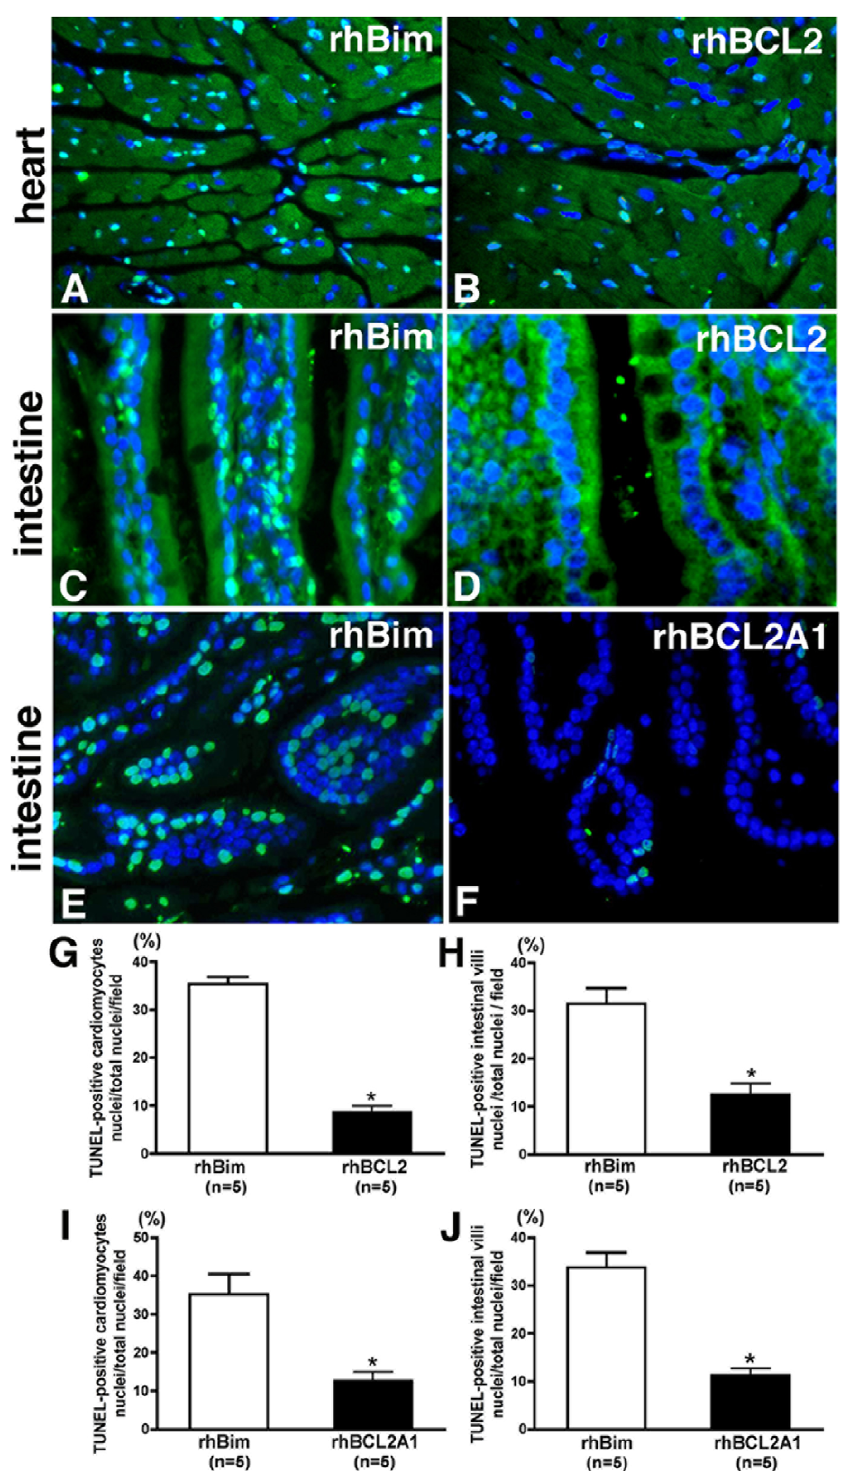
Figure 2. Treatment with rhBCL2 or rhBCL2A1 reduces apoptosis in intestine and myocardium following CLP. Animals were treated with a single i.p. injection of 1 m g rhBim or rhBCL2 or rhBCL2A1 at 18 hours prior to CLP. Tissues were removed and processed at 24 hours following CLP. In the photomicrograph (A-F) TUNEL-positive cells are labeled with FITC (green) and nuclei are labeled with DAPI (blue). Panels A and B shows myocardium from mice treated with rhBim (A) or rhBCL2 (B). Panels C-F show intestinal villi from mice treated of rhBim (C, E), rhBCL2 (D) or rhBCL2A1 (F). The graph shows quantitation of TUNEL-staining in cardiomyocytes (G, I) or intestine (H, J) following treatment with rhBim or rhBCL2 (G, H) or rhBCL2A1 (I, J). The number of TUNEL-positive cells in mice treated with rhBim was significantly greater than in mice treated with rhBCL2 or rhBCL2A1. *p , 0.05.